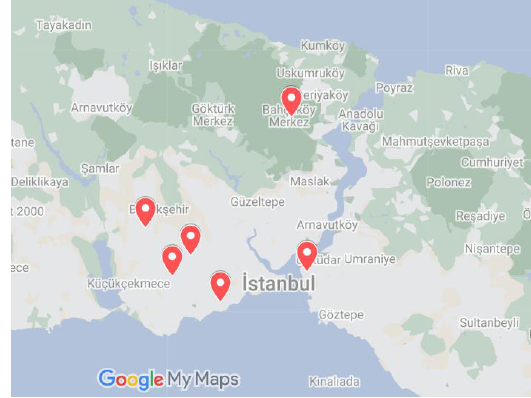
Figure 1 . The location of the selected collapsed buildings. The locations and the collapsing dates are shown in Table 1.